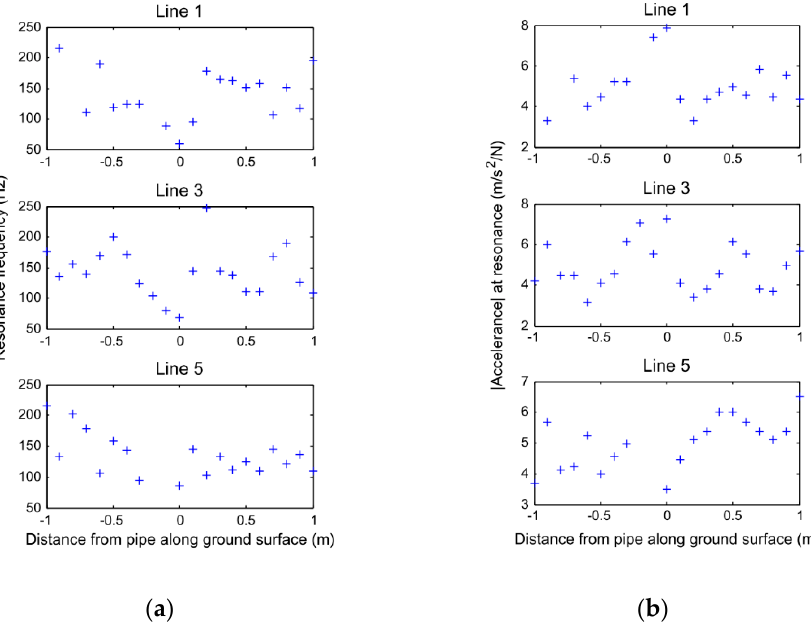
Figure 10. Detection results of point vibration measurements: ( a ) resonance frequencies along measurements lines; ( b ) accelerance magnitude at the resonance along measurement lines [90].